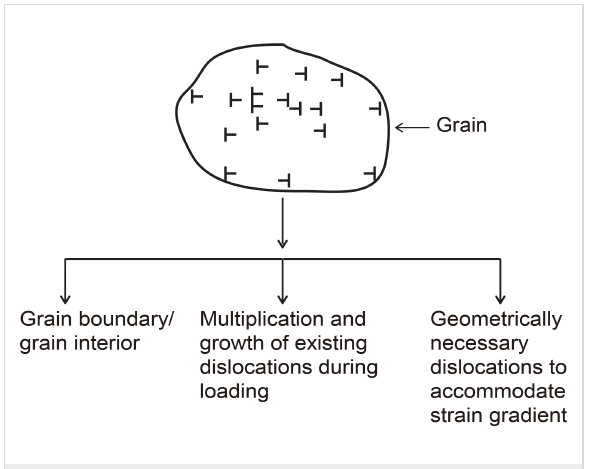
Figure 1: Flowchart illustrating dislocation sources, in a grain, from the grain boundary and the grain interior, from multiplication and growth of an existing dislocation and from geometrically necessary dislocations needed to accommodate strain gradient.